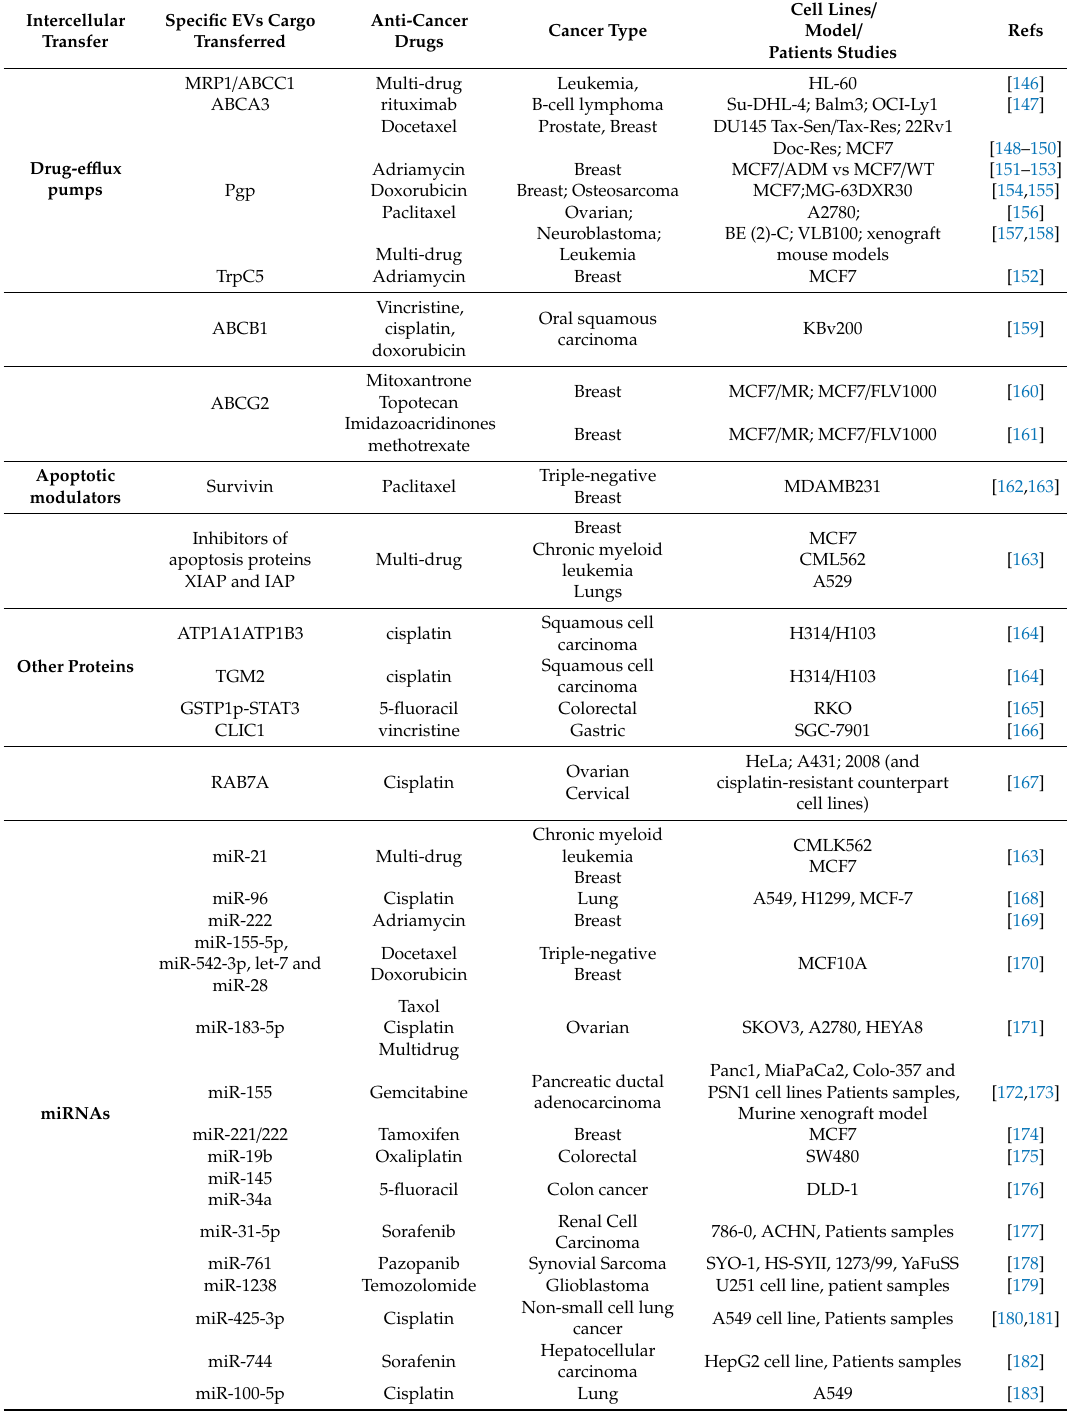
Table 2. Intercellular transfer of drug resistant traits between resistant and sensitive cancer cells according to anti-cancer drug and cancer